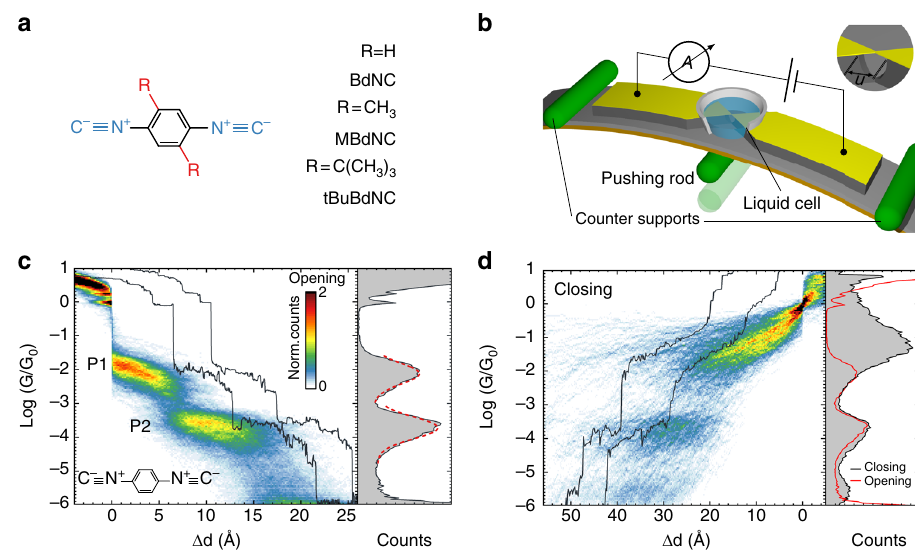
Fig. 1 Double plateau formation in isocyano compounds. a Structural formula of measured compounds. b Schematics of MCBJ setup for liquid measurements. c Overview of BdNC measurements: 1445 opening conductance traces at 0.1 V bias voltage in 100 μ M solution in THF:Mesitylene 1:4 (v/v). Central panel: conductance-displacement histogram and two typical opening traces. The histogram displays the counts per bin on a linear scale with 25 bins per decade of conductance and a bin size of 0.15 Å for displacement. Sample traces are shifted horizontally for clarity. Right panel: conductance histogram with 25 bins per decade. Red dashed curves represent Gaussian fi t of the conductance peaks. d Overview of closing traces analysis: 1445 traces at 0.1 V bias voltage in 100 μ M BdNC solution. Central panel: conductance-displacement histogram and two typical closing traces. Right panel: conductance histogram with 25 bins per decade; red curve: conductance histogram of opening traces shown in ( c